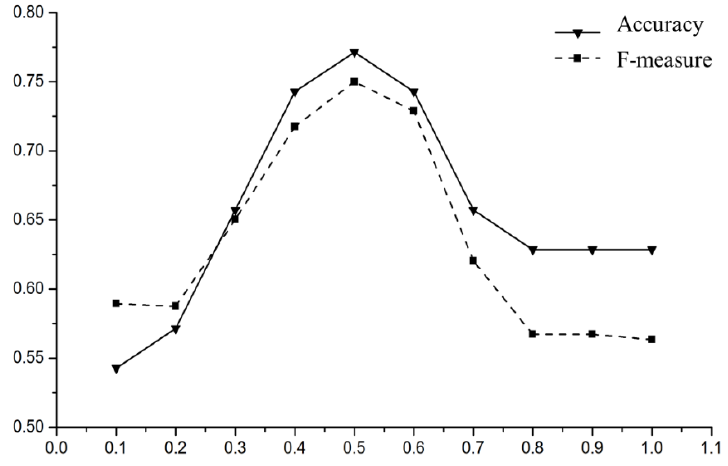
Figure 8. Accuracy and F − Measure change in feature weight coefficient λ = [0.1, 1]. Figure 8. 𝐴𝑐𝑐𝑢𝑟𝑎𝑐𝑦 and 𝐹 − 𝑀𝑒𝑎𝑠𝑢𝑟𝑒 change in feature weight coefficient λ = [0.1, 1]. Table 5. Performance comparison between LDA model and TC-LDA model. Model Accuracy Precision